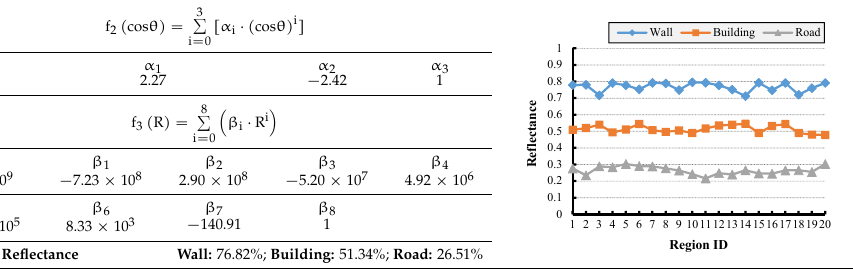
Table 8. Absolute correction results (reflectance) of the three surfaces of the polynomial method.